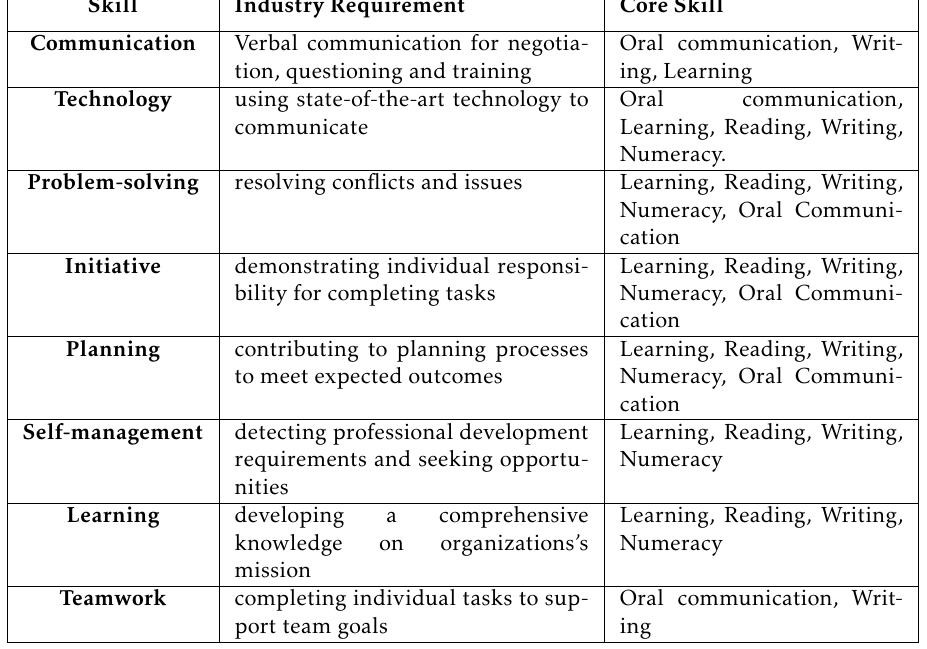
Table 1. Employability skills from the Business Services Training Package and how these relate to ACSF core skills [1]